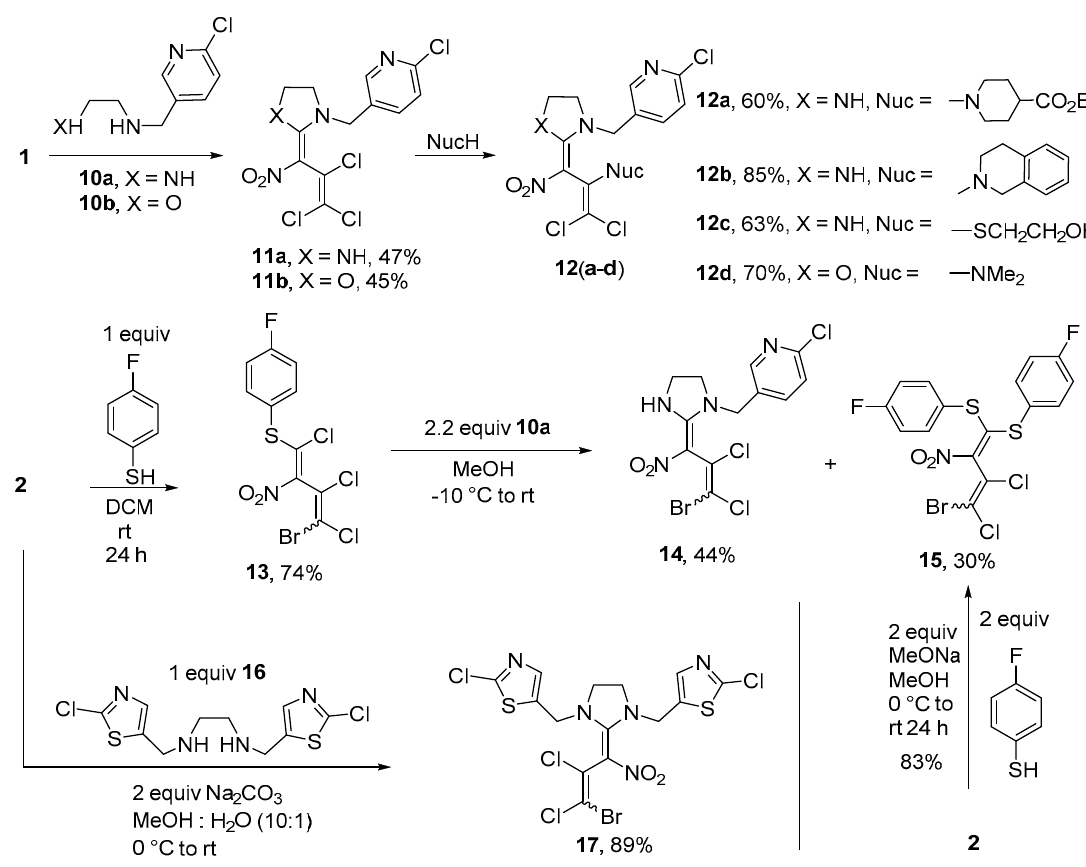
Scheme 4. Synthesis of Imidacloprid analogues 11 , 12 , 14 , 17